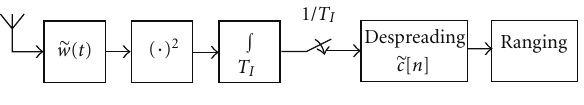
Figure 2: Energy